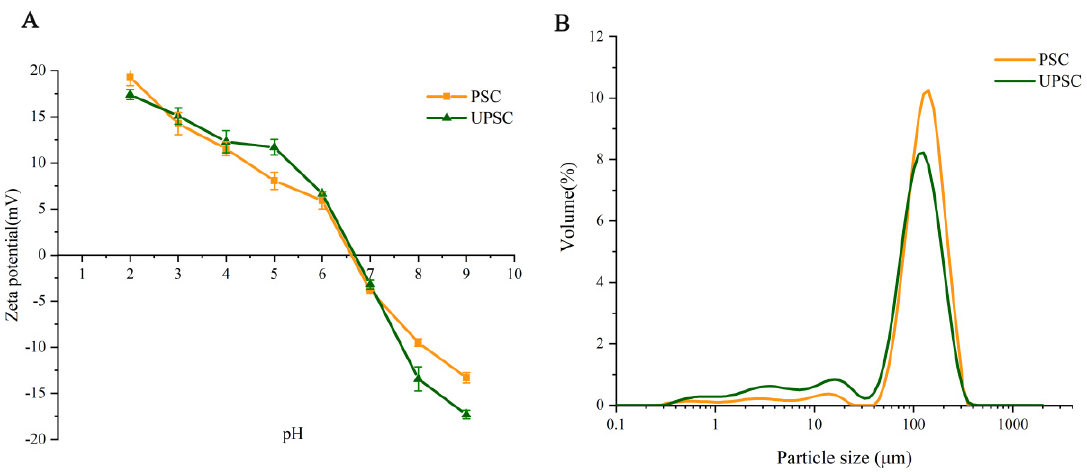
Figure 3. Bactrian camel skin collagen samples’ zeta potential ( A ) and particle size ( B ) (PSC, pepsin- solubilized collagen; UPSC, ultrasound-treated pepsin-solubilized collagen).